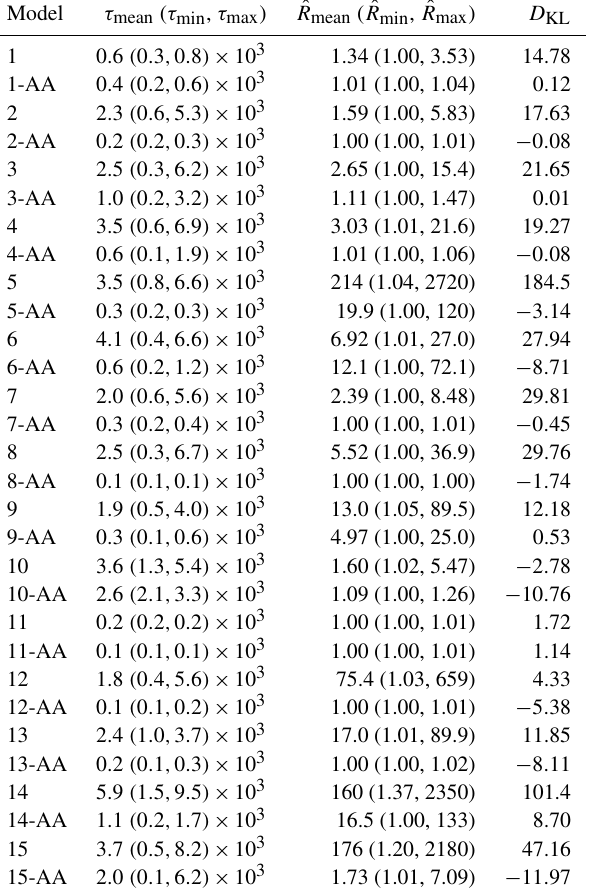
Table 4. Performance metrics for each MCMC run: mean (best-case, worst-case) integrated autocorrelation time τ in sam- ples ( × 10 3 ); mean (best-case, worst-case) potential scale reduction factor ˆ R calculated across four runs starting from independent prior draws; and sample Kullback–Liebler divergence D KL between the given model and the fine-mesh anti-aliased version, calculated by combining samples from all four runs thinned by a factor of 1000. Runs marked with “AA” are coarse-mesh anti-aliased, while those marked with only a single-digit model number have anti-aliasing turned off.